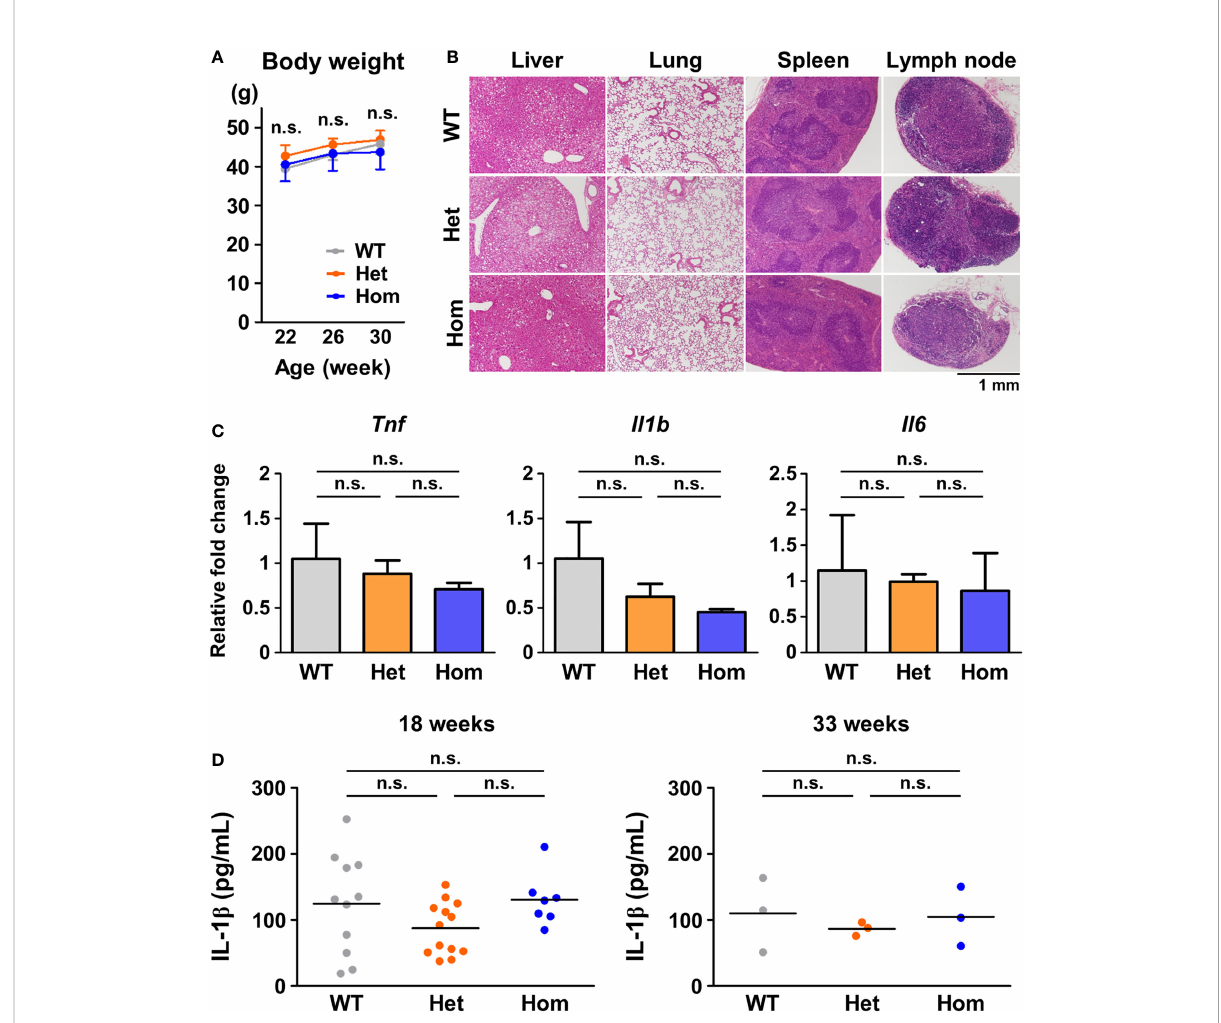
FIGURE 1 No detectable in fl ammatory phenotypes in G87V TRAPS mutant mice under standard housing conditions. (A-D) G87V TRAPS mutant mice were observed until the age of 33 weeks under standard housing conditions. (A) Body weights. (B) Representative histological images of stained tissue sections at 33 weeks of age. The liver, lung, spleen, and inguinal lymph node were stained with hematoxylin and eosin. (C) mRNA expression in the whole blood of the G87V mutant mice at 33 weeks of age ( n = 3 each). Whole blood RNA samples were collected by using PAXgene RNA collection tubes. Gene expression levels relative to Hprt were calculated and normalized to the expression level of the WT mice. (D) Serum concentrations of IL-1 b were determined by ELISA at 18 and 33 weeks of age. Each dot denotes an individual mouse. Values are presented as means ± standard deviation. TRAPS, Tumor necrosis factor (TNF) receptor-associated periodic syndrome; IL, interleukin; WT, wild-type; Het, heterozygote; Hom, homozygote; n.s., not signi fi